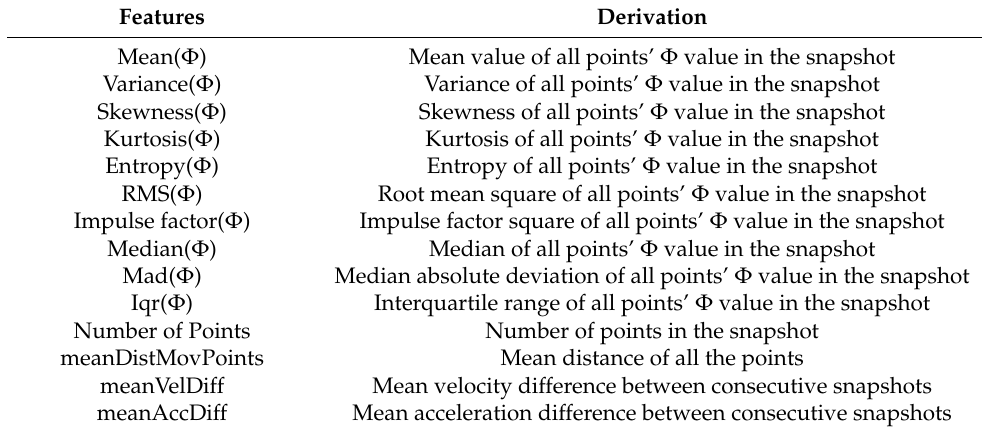
Table 2. Features made up the dataset fed to ML